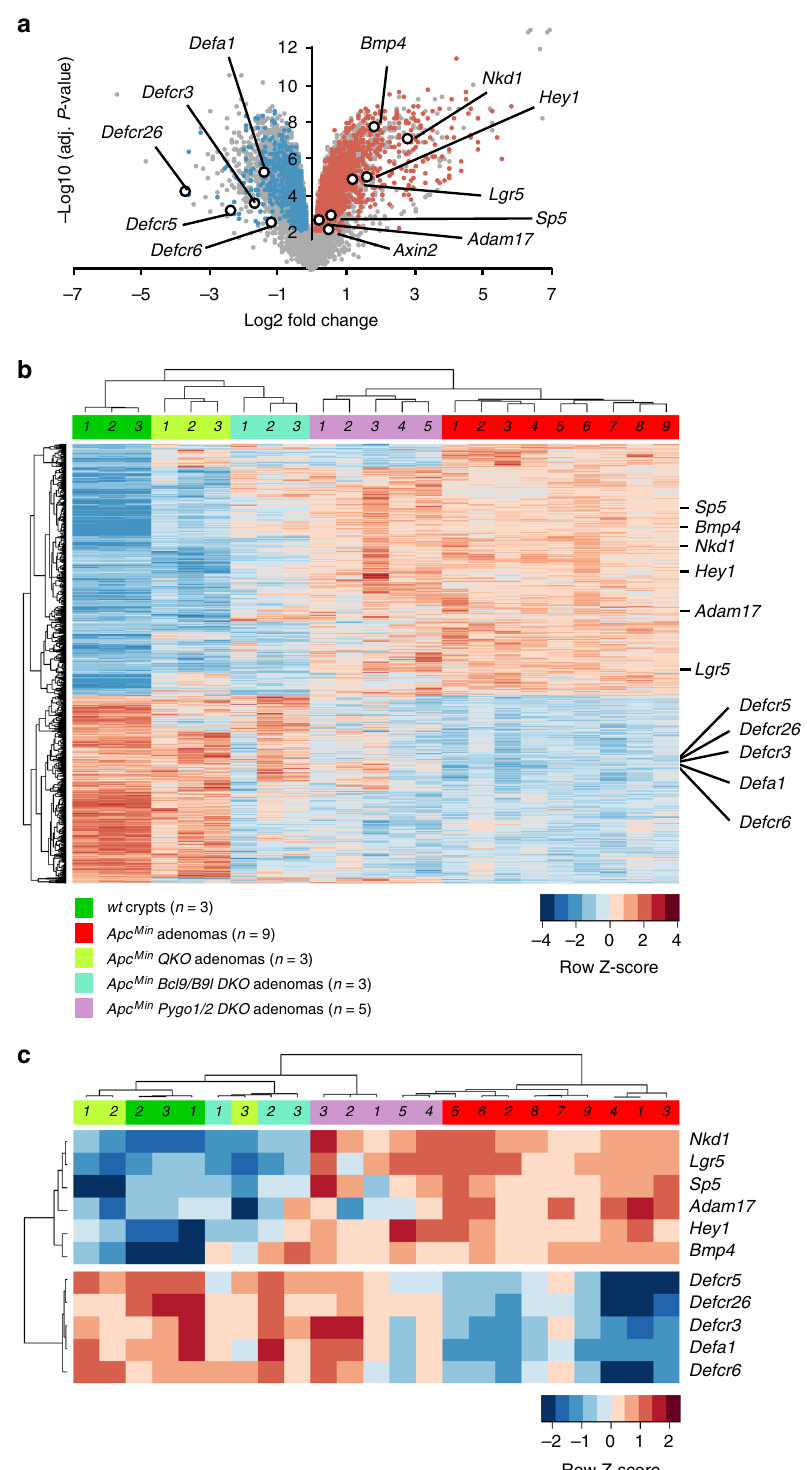
‘ default ’ cell fate within the intestinal epithelium 31 whose speci fi cation requires neither β -catenin nor Math1 32,33 . Redistribution of β -catenin in Bcl9 -deleted Apc Min adenomas . The above-described RNA pro fi le changes do not fully explain why the tumour phenotypes caused by Bcl9 loss differed